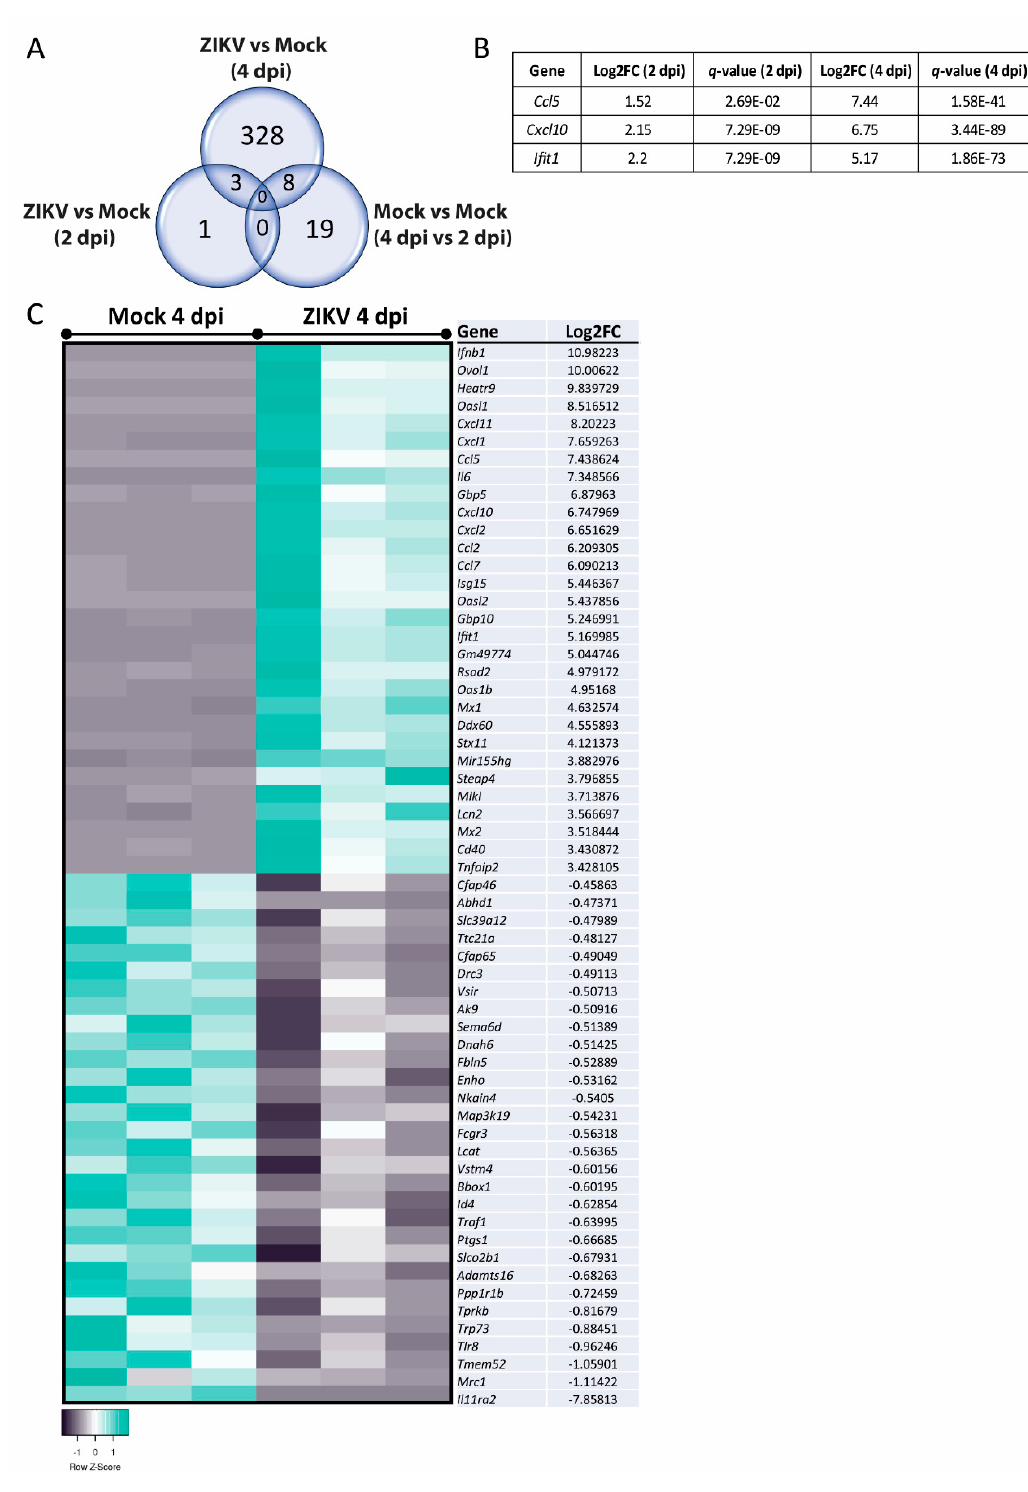
Figure 4. Ccl5 , Cxcl10 , and Ifit1 were upregulated in mature CNS cultures at 2 dpi and 4 dpi. ( A ) Comparison of differentially expressed genes (DEGs) in ZIKV-infected versus mock-infected mature CNS cultures, at 2 dpi and 4 dpi; there were 19 DEGs unique to the dataset comparing mock-infected cultures at 4 dpi with mock-infected cultures at 2 dpi. ( B ) ZIKV-infected cultures shared three DEGs; Ccl5 , Cxcl10 , and Ifit1 , with upregulation data shown in the table. ( C ) The transcriptomic analysis of independent biological replicates ( n = 3) of ZIKV-infected mature CNS cultures at 4 dpi revealed more than 300 DEGs with a q -value < 0.05. The heatmap displays the top 30 up- or downregulated genes between mock- and ZIKV-infected mature CNS cultures. The heatmaps were generated with the online tool Heatmapper [77] .